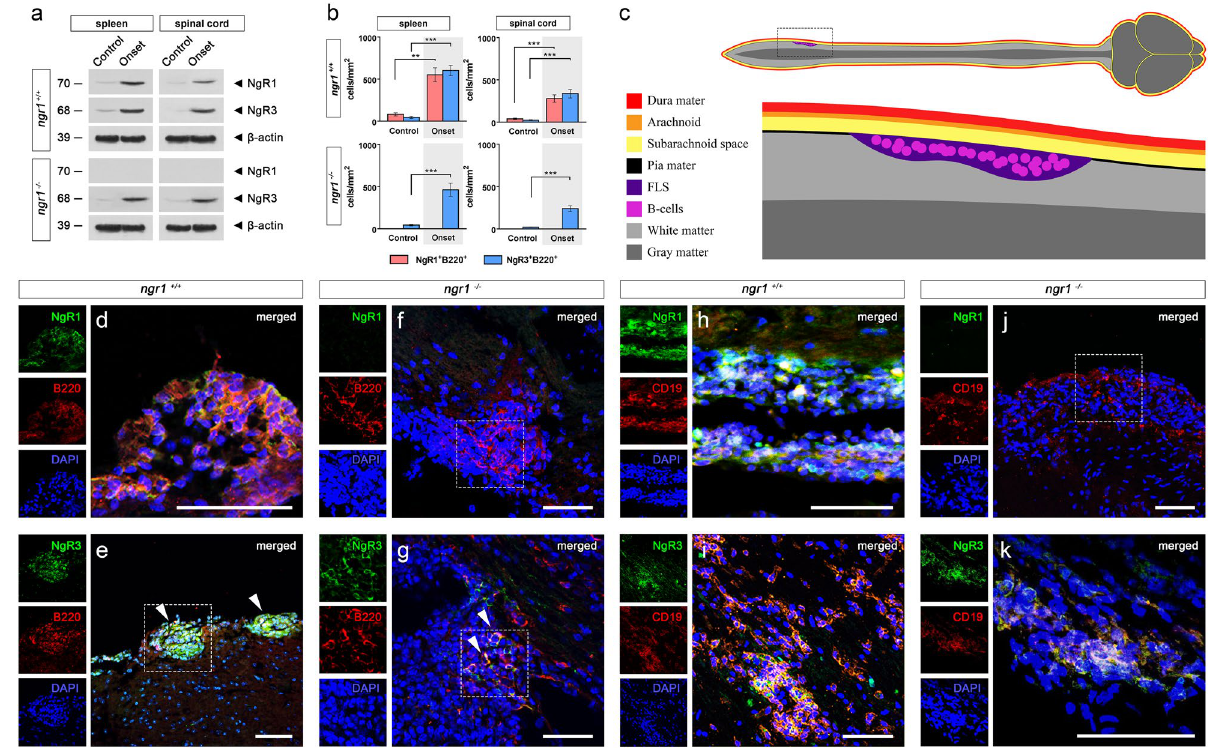
Figure 2. NgR1 and NgR3 are localized to B-cells within lymphoid-like follicles of the spinal cord. ( a ) Western blot of spleen and spinal cord extracts from ngr1 + / + and ngr1 −/− mice showcasing the expression of NgR1 and NgR3. β-actin was used as a loading control. ( b ) Semi-quantitative analysis of both NgR1- and NgR3-positive B-cells per unit area (mm y ) of spleen and spinal cord infiltrates for the ngr1 + / + and ngr1 −/− mice (n = 34 ngr1 + / + mice; 108 sections, n = 15 ngr1 −/− mice; 40 sections) during the onset of EAE. These B-cells demonstrated a highly inducible receptor expression (student’s t test with Bonferroni correction *** p < 0.001 and ** p < 0.01) compared to controls. ( c ) Illustration of inflammatory infiltrates analyzed via immunofluorescence immunolabeling of follicle-like structures (FLS) within the lumbosacral spinal cords of EAE-induced mice in ( d – k ). ( d ) Representative NgR1 and B220 double-labeled images showing the expression on clusters of B-cells localized to infiltrates around the leptomeninges during the onset of EAE in ngr1 + / + mice. ( e ) Representative NgR3 and B220 double-labeled images showing the expression on clusters of B-cells localized to infiltrates around the leptomeninges during the onset of EAE in ngr1 + / + mice (hatched boxes). ( f ) Representative images for the ngr1 −/− mice, highlighting the absence of the NgR1 protein expression in clusters of B-cells in similar infiltrates of the leptomeninges during the onset of EAE (hatched boxes). ( g ) Representative images for the ngr1 −/− mice, highlighting the strong expression of the NgR3 protein expression in clusters of B-cells in similar infiltrates of the leptomeninges during the onset of EAE (hatched boxes). ( h ) Representative NgR1 and CD19 double-labeled images showing the expression on clusters of B-cells localized to infiltrates around the leptomeninges during the onset of EAE in ngr1 + / + mice. ( i ) Representative NgR3 and CD19 double-labeled images showing the expression on clusters of B-cells localized to infiltrates around the leptomeninges during the onset of EAE in ngr1 + / + mice. ( j ) Representative images for the ngr1 −/− mice, highlighting the absence of the NgR1 protein expression in clusters of CD19 + B-cells in similar infiltrates of the leptomeninges during the onset of EAE (hatched boxes). ( k ) Representative images for the ngr1 −/− mice, highlighting the strong expression of the NgR3 protein expression in clusters of CD19 + B-cells in similar infiltrates of the leptomeninges during the onset of EAE. Scale = 50 Immunoglobulin‑specific phenotyping of B‑cell infiltrates expressing NgR1 and NgR3 during EAE at the onset of EAE. B-cells expressing either NgR1 and/or NgR3 were isolated from the spinal cords of EAE-induced ngr1 + / + and ngr1 −/− mice and phenotyped according to their membrane-bound immunoglobu- lins, to investigate potential humoral/immunopathogenic roles of NgR. Flow cytometric analysis was performed on immune cells isolated from lumbar spinal cord at disease onset were stained with fluorescently tagged anti-NgR1 and 3, anti-B220, anti-IgM and IgD antibodies. Representative results showed that the majority of cells (> 80%) expressed high levels of cell surface IgG and low levels of IgM with a minor proportion (~ 12%) co-expressing high amounts of IgG and IgM (Fig. 4a,b). Furthermore, IgD was co-expressed on small proportion (~ 1%) of cells expressing high levels of IgM. Similar results were generated in ngr1 −/− mice. The majority of double-positive IgG + B-cells (96.6%) were not cycling based on Ki-67 labeling (Fig. 4c,d). These data suggest that the isolated spinal cord B-cells from EAE-induced mice that express NgR have matured and underwent immunoglobulin class switching.